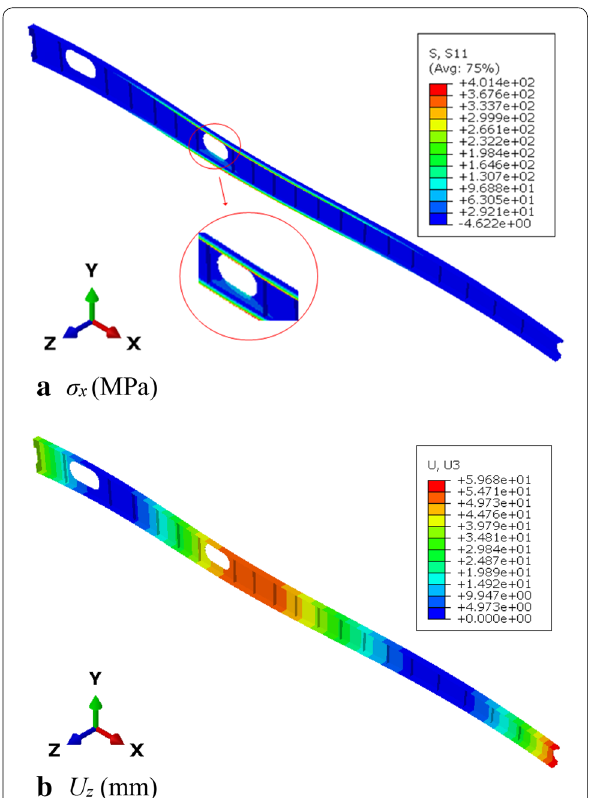
Figure 2 σ x and U z of the first mode of the long stringer under the damping ratio of 0.012